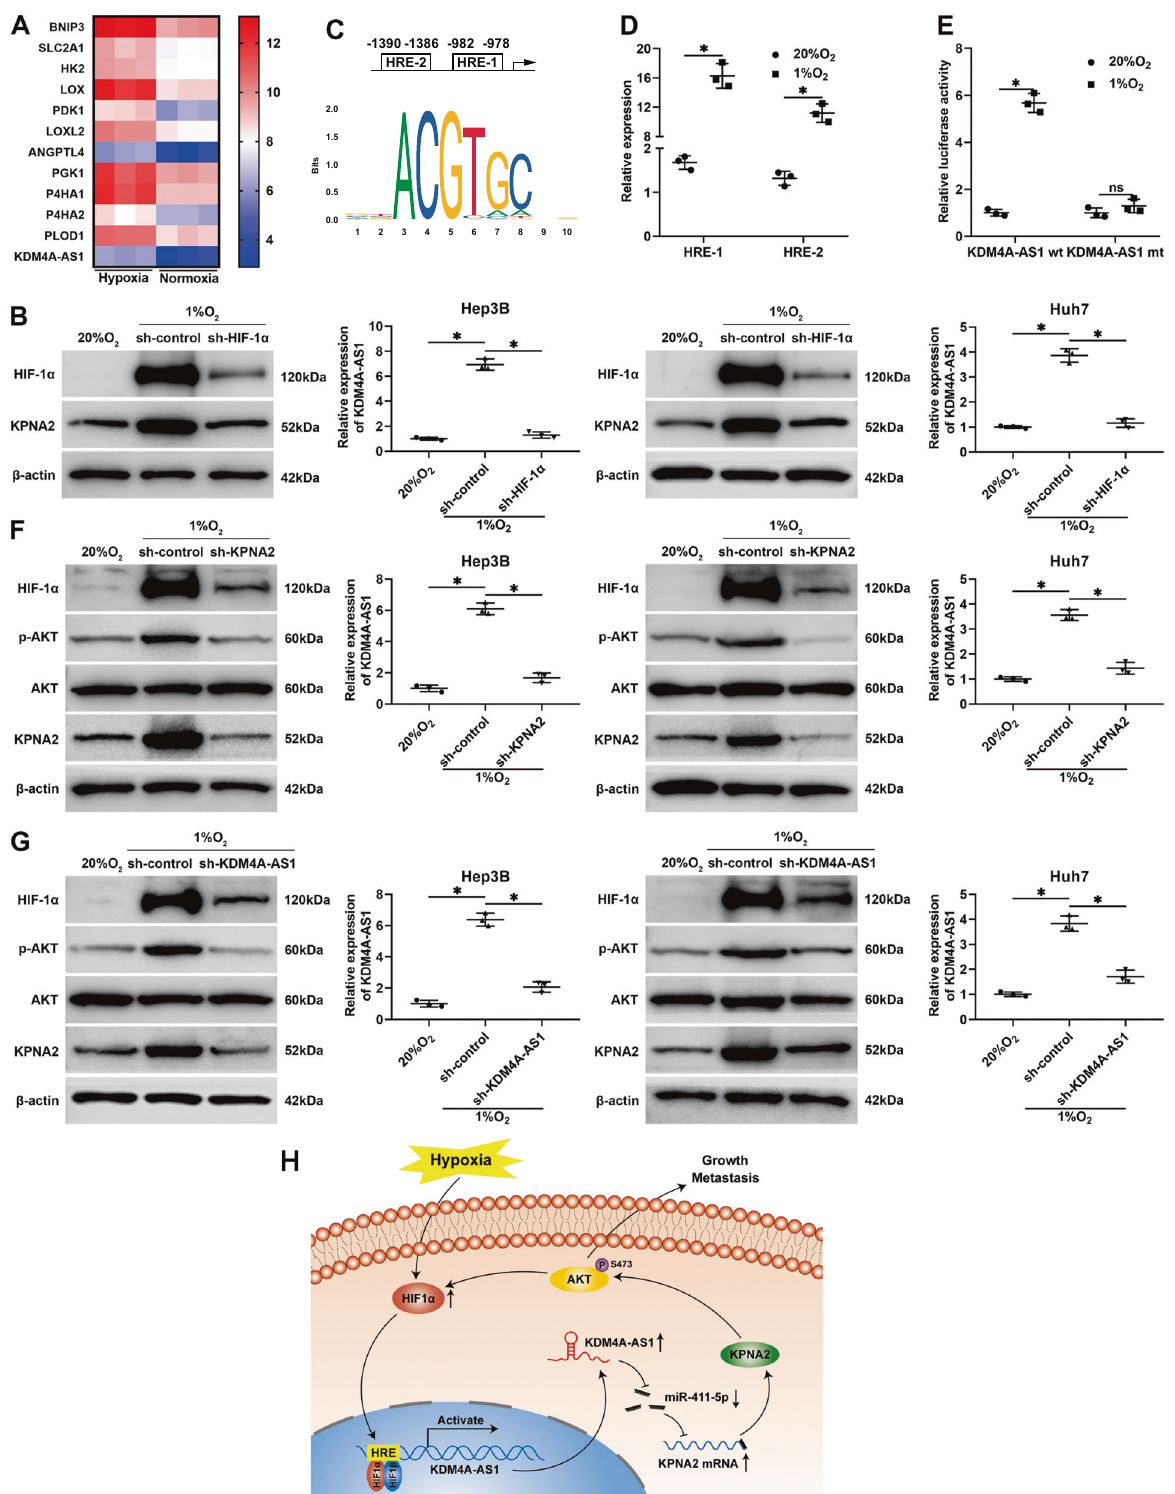
and western blotting assay showed that miR-411-5p negatively regulated KPNA2 in both RNA and protein levels.